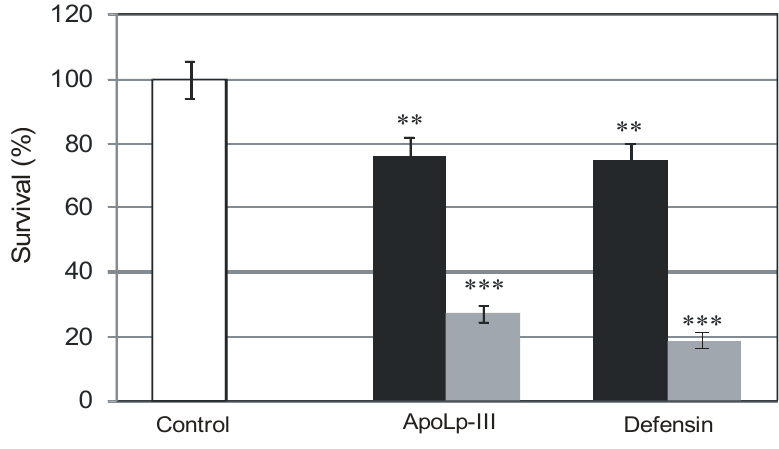
Figure 2. The effects of G. mellonella apoLp-III and defensin on L. dumoffii survival and influence of choline supplementation on the activity of the antimicrobial factors. The bacteria cultured on the non-supplemented (black bars) and choline-supplemented (grey bars) medium were exposed to Galleria defensin (40 μ g/mL) or apoLp-III (0.4 mg/mL), as described in the Experimental Section. After seeding of the bacteria on the agar plates, the growing colonies were counted. Survival of the untreated cells was regarded as 100% (C; control). The results are given as mean ± SD from three independent